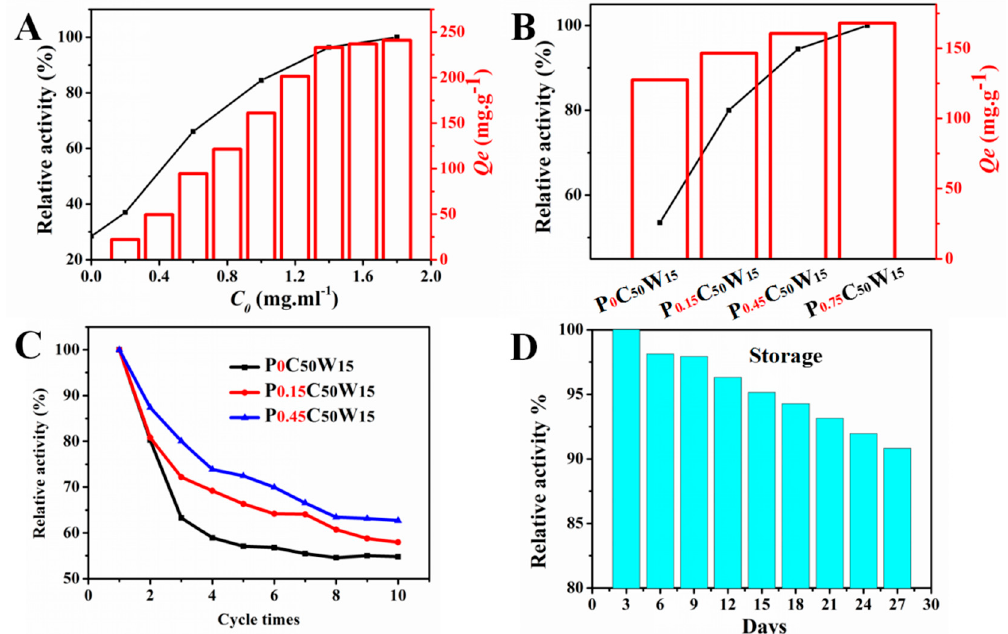
Figure 13. ( A ) Immobilizing β -amylasesintoP 0.75 C 50 W 15 conducted under enzyme solutions (pH = 6) with different enzyme concentration; ( B ) under enzyme concentration of 1.0 mg/mL (pH = 6), immobilizing β -amylases into P X C 50 W 15 and P 0 C 50 W 15 ; ( C ) the reusability of immobilized β -amylases prepared by P 0.15 C 50 W 15 , P 0.45 C 50 W 15 and P 0 C 50 W 15 under enzyme solution (1.4 mg/mL) with pH = 5; ( D ) the storage stability of